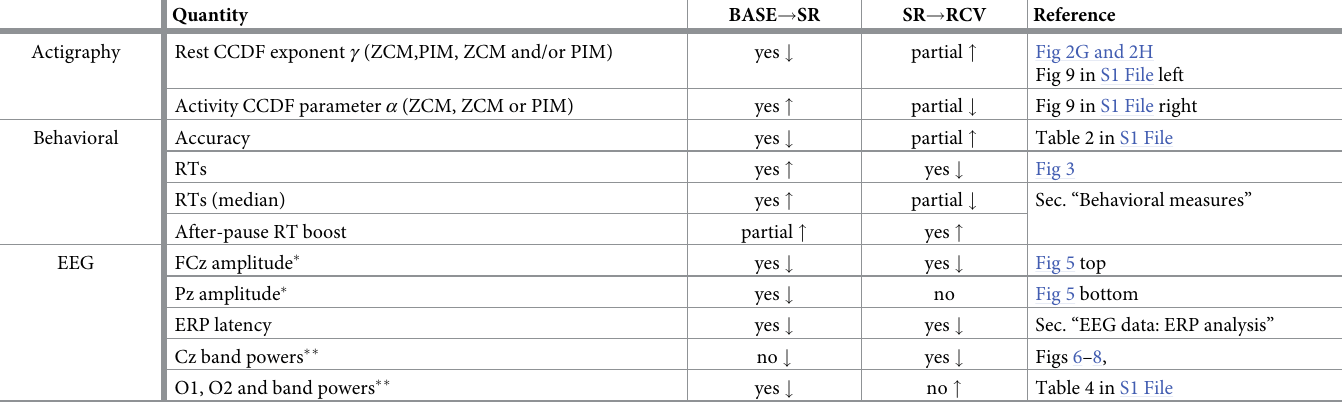
Table 1. A simplified summary of the results where the difference between baseline and sleep restriction or recovery was found significant. The arrows " and # indi- cate increase or decrease of a given measure. Partial return indicates a tendency for a given measure to go back to baseline value, even if they still remain different. � FCz amplitude at 272 ms, Pz at 600 ms. �� Delta, theta and alpha bands at Cz; delta and alpha bands at O1,